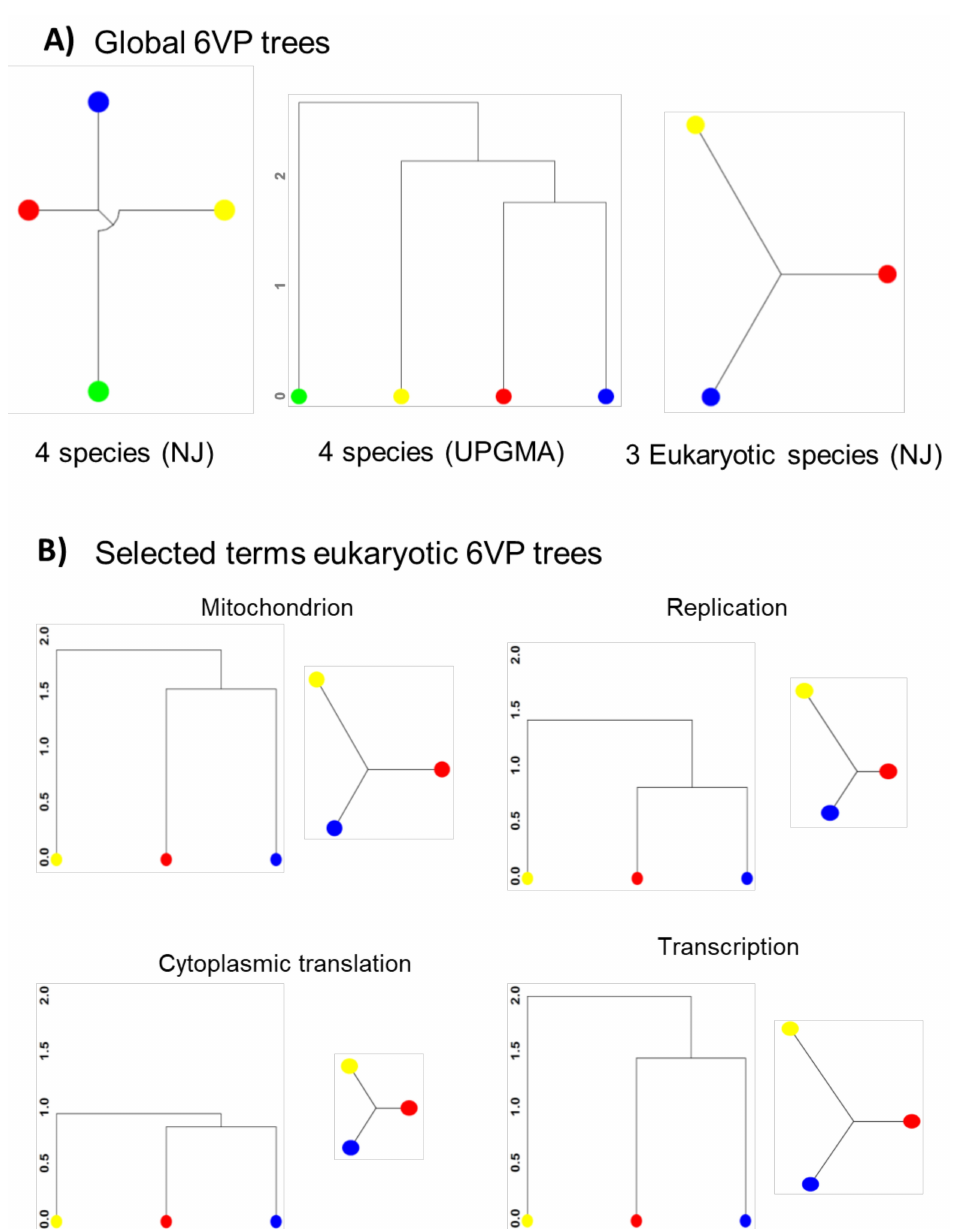
Figure 5. Phenograms of the four organisms based on their 6VPs. ( A ) Global neighbor-joining (NJ) and UPGMA trees based on the 6VPs derived from 53 GO Biological Process (BP) and 2 GO Cellular Component (CC) terms for S. cerevisiae (red dots), S. pombe (blue dots), E. coli (green dots) and H. sapiens (HeLa cell line, yellow dots) (left and center), or only the NJ tree for the three eukaryotes with 353 GO BP, plus 84 GO CC terms (right). ( B ) NJ and UPGMA trees based on the available GO terms linked (manually curated) with cytoplasmic translation, transcription, mitochondrion and replication. All the NJ and UPGMA unrooted trees are, respectively, on the same scale, but NJ and UPGMA are represented with a different kind of branching to show complementary information. The lists of the GO terms used in each tree are provided in Supplementary Table S5. Additional phenograms for other GO terms are shown in Supplementary Figure